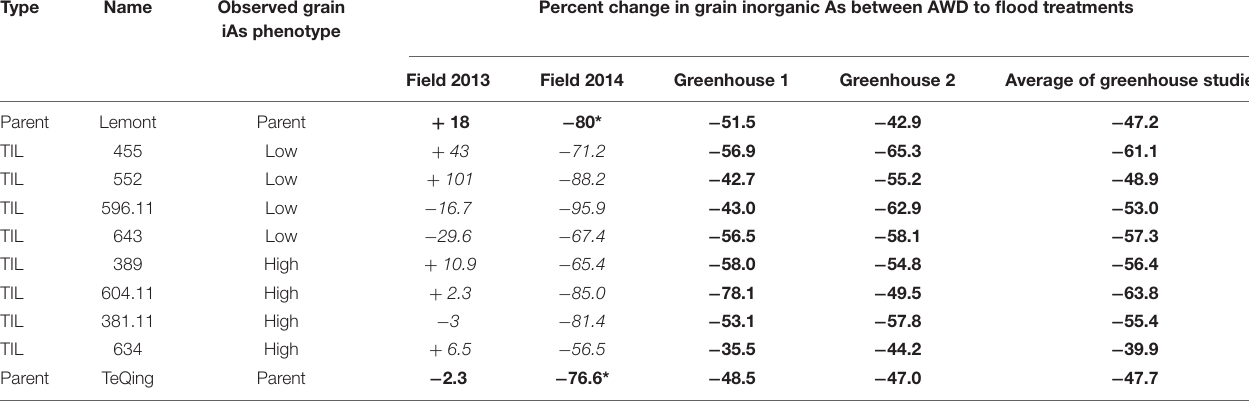
FIGURE 4 | Comparison of brown rice inorganic arsenic concentrations for eight TILs and their parents. Genotypes were grown in the field in 2013 and 2014 and in two greenhouse studies (Greenhouse 1 and Greenhouse 2) in 2019 under alternate wetting and drying (AWD) (A) and flooded (B) irrigation management practices. Error bars represent standard deviation of biological replicates ( n = 4 in 2019 for each greenhouse, and n = 6 in 2013 and 2014 for parents only). Dotted line represents FDA limit of 100 µ g kg - 1 for inorganic arsenic in rice-based infant food. TABLE 3 | Percent change in brown rice inorganic arsenic of eight TILs and their parents from AWD to flood treatments in studies conducted in the field and